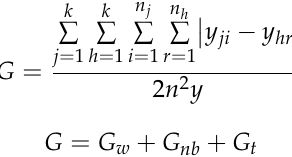
Table 4. Gini coefficient and its decomposition results from 2008 to 2020.